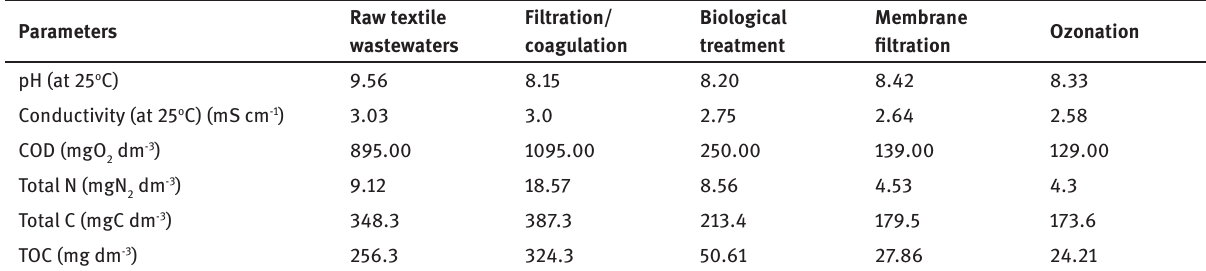
Table 1: Parameters of raw textile wastewaters and after successive purification stages [1].